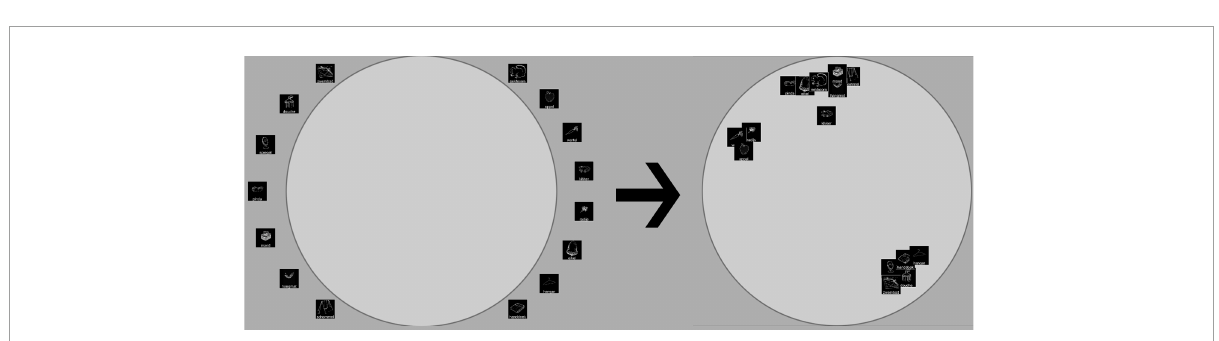
FIGURE3 The experimental setup: Participants are presented with a set of stimuli around a circle as seen on the left and then sort these items by similarity to create an arrangement as seen on the